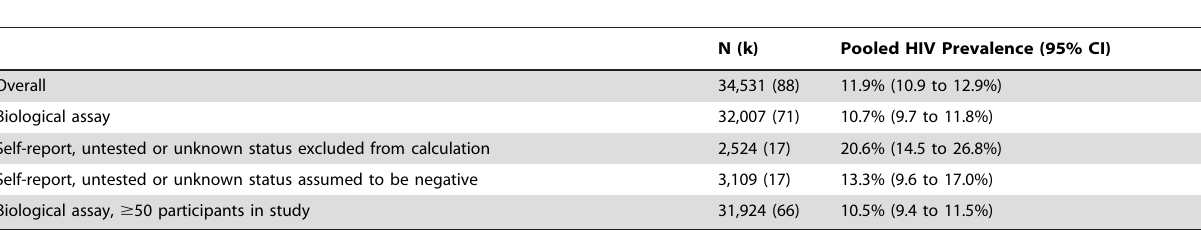
Table 1. Pooled HIV prevalence by HIV measurement and sample